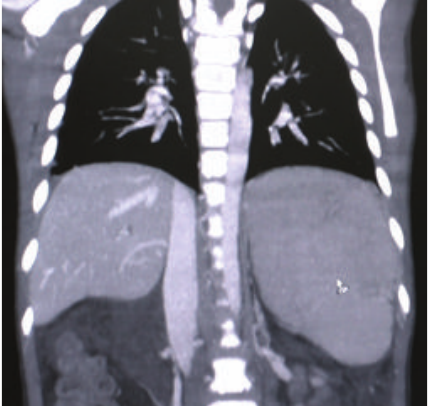
Figure2:Patient’sCTangiographyoftheabdomenrevealedspleno-